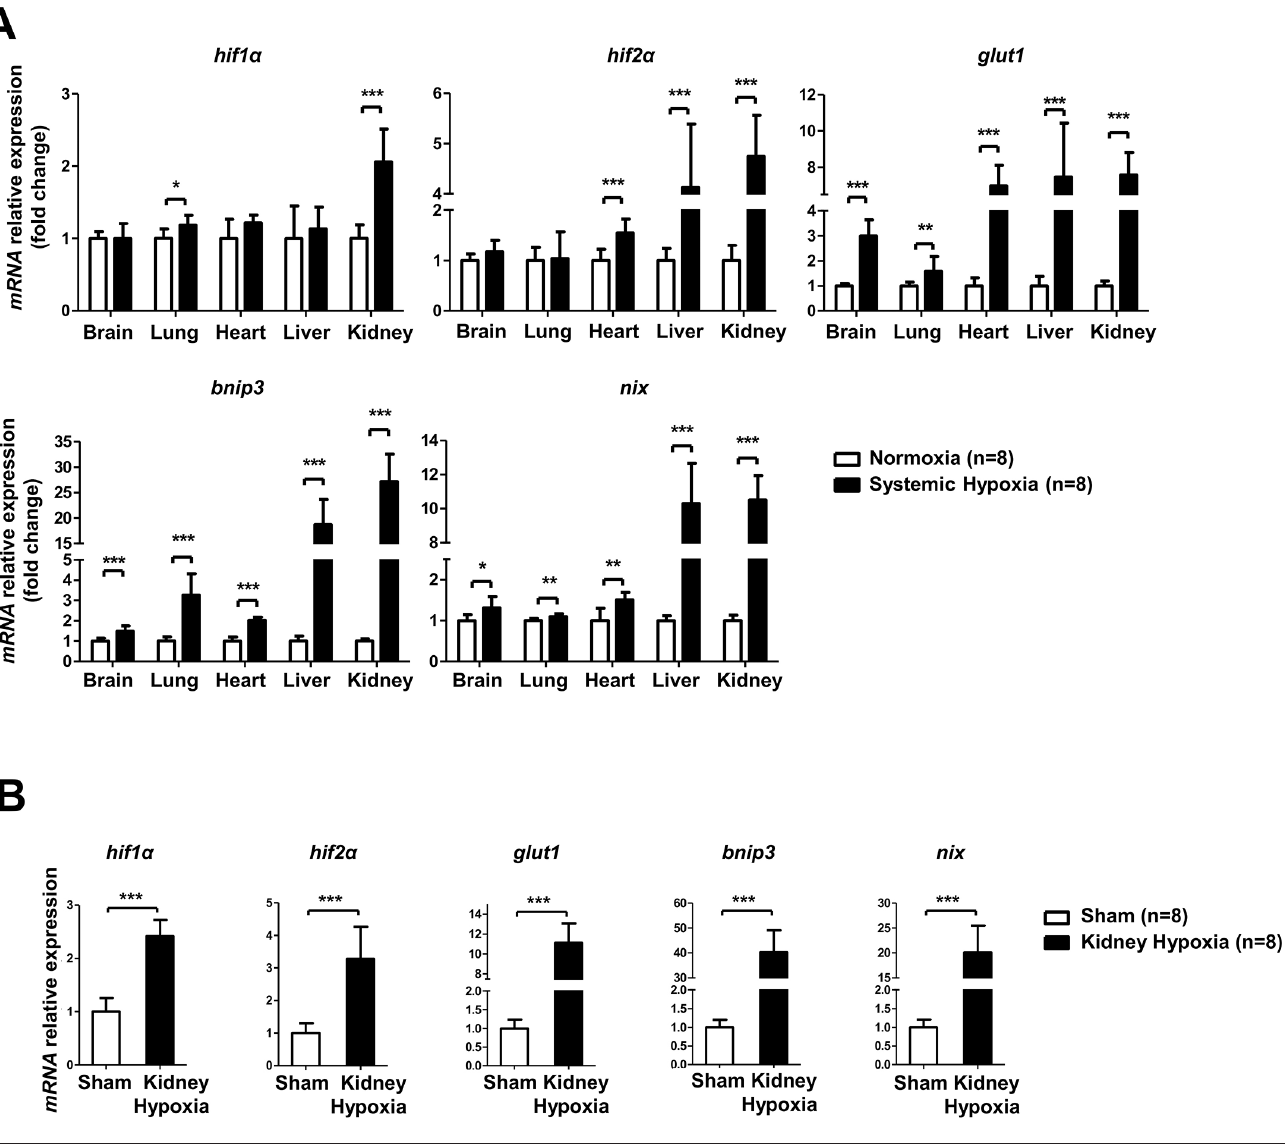
Figure 1. Systemic hypoxia and local kidney hypoxia induced HIF-1 α activation in a rat model. Six-to-eight-week-old male Sprague- Dawley rats were randomly divided into normoxia (n = 8), systemic hypoxia (7500 m, 7 h; n = 8), sham (n = 8) and local kidney